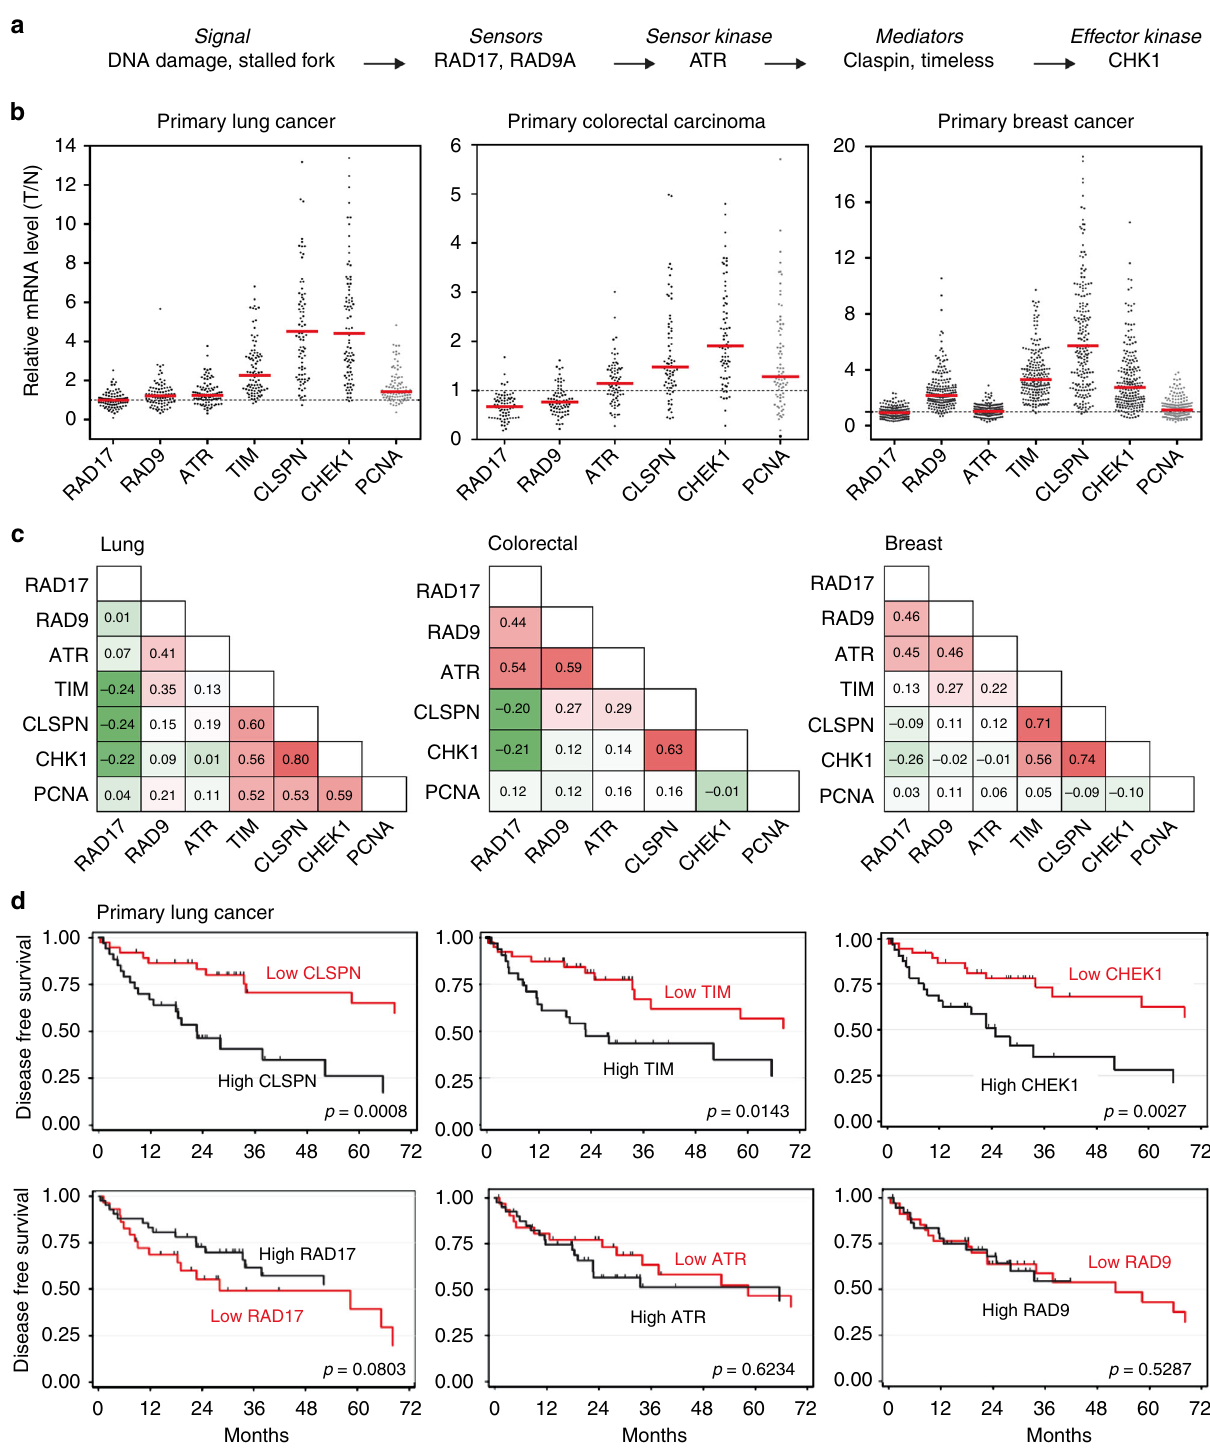
Fig. 1 Claspin, Timeless, and CHK1 mRNA are overexpressed in primary colorectal, lung, and breast cancers. a Schematic representation of the ATR pathway showing the six checkpoint factors analyzed in this study. b Relative mRNA levels of ATR, RAD9, RAD17, Claspin, Timeless, CHK1, and PCNA in 93 lung tumors, 74 primary colorectal carcinomas, and 206 breast cancer samples. mRNA levels were determined by quantitative RT-PCR and are expressed as the ratio of tumor (T) to normal tissues (N). c Nonparametric Spearman correlation analysis of the expression of checkpoint genes and proliferation marker (PCNA) in lung, colorectal, and breast cancer samples. d High expression of Claspin, Timeless, and CHK1 is associated to bad prognosis in NSCLC patients. Disease-free survival (DFS) according to gene level expression: Claspin, Timeless, CHK1, RAD17, ATR, and RAD9. Totally, 72 patients were analyzed